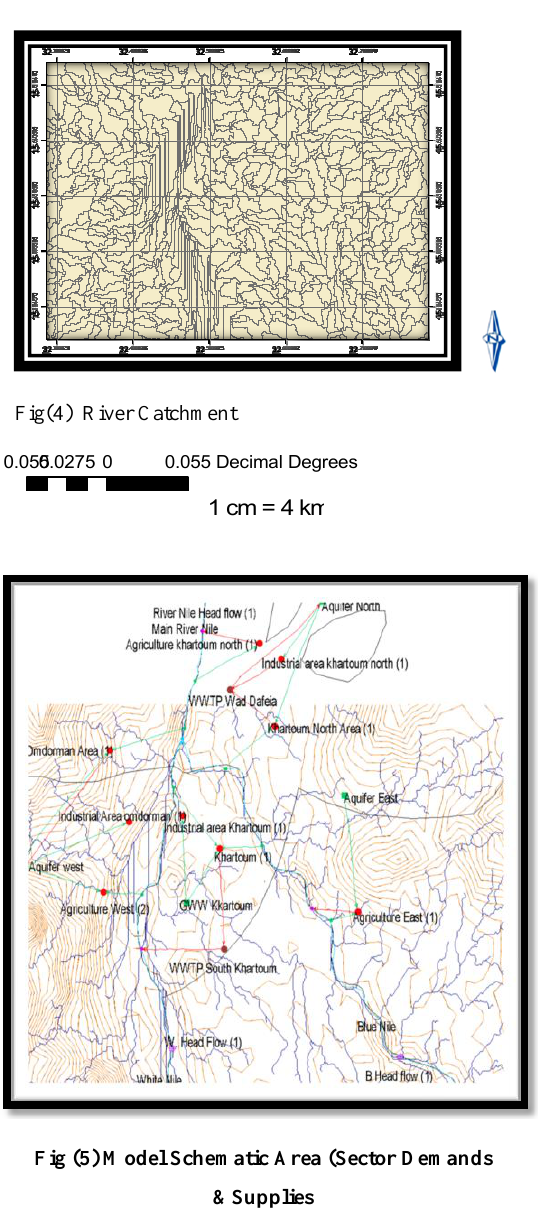
Table (1) the waste water inflows and outflows to